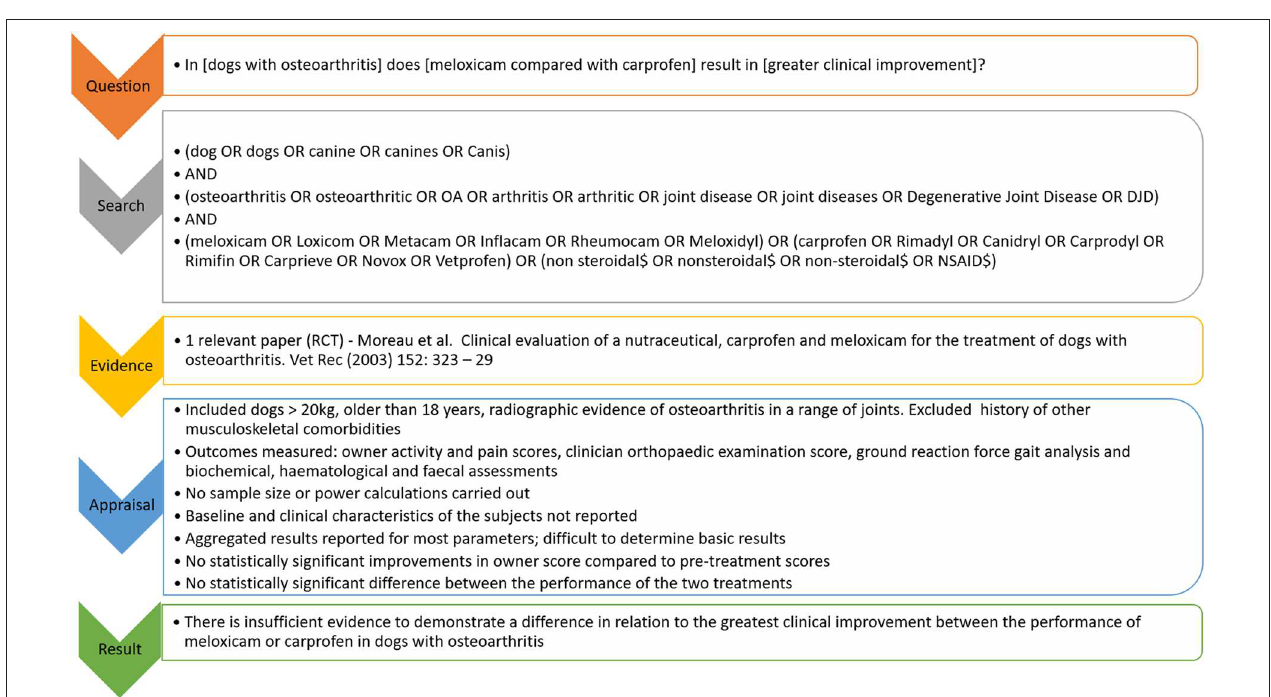
FIGURE 3 | Overview of the example CAT provided on the use of NSAIDs (meloxicam vs. carprofen) in dogs with